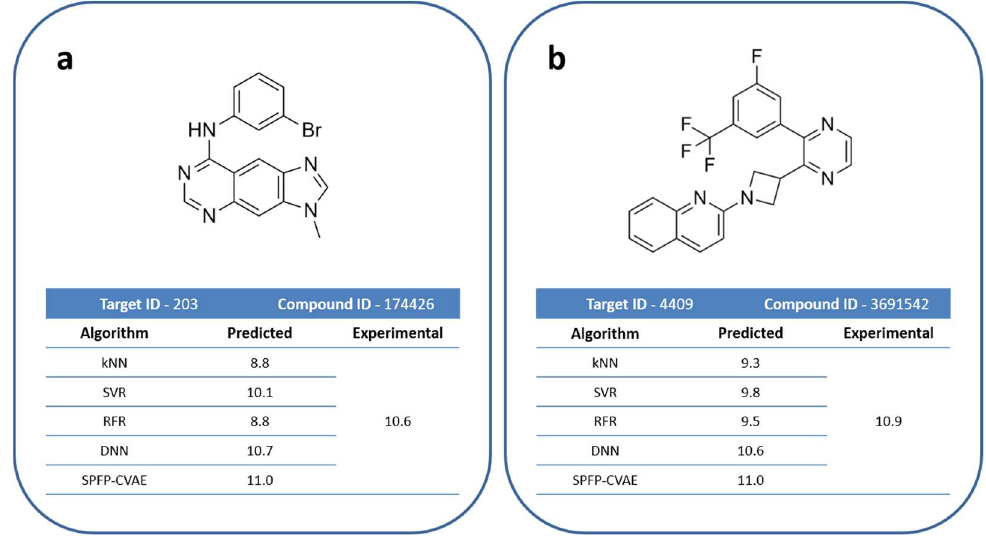
Figure 9. Highly potent compounds. ( a ) and ( b ) illustrate predictions for two exemplary highly potent test compounds using different methods.